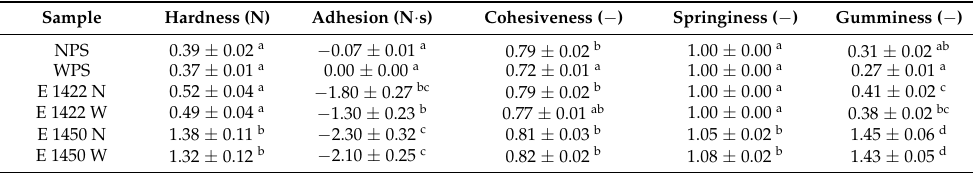
Table 2. The texture of the pastes of aerogels of concentration of